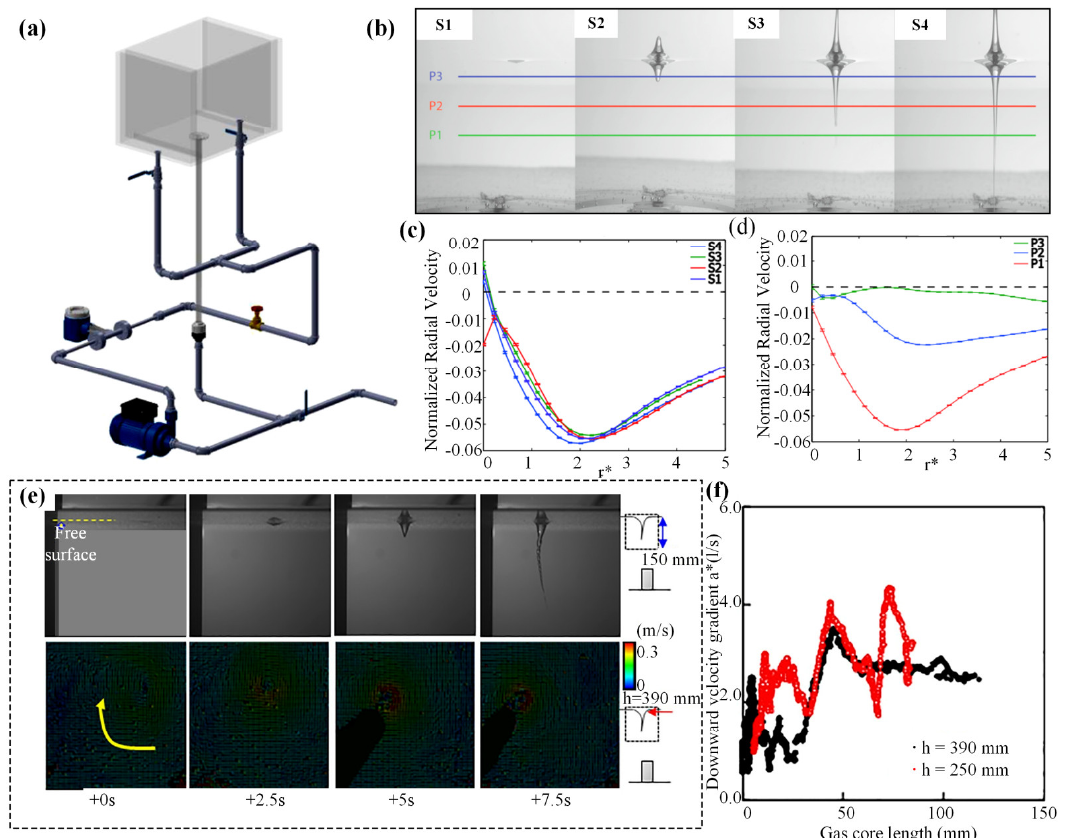
Figure 14. Flow characters of free sink vortex over time. ( a ) Experimental apparatus of gas entrain- ment. ( b ) Different development stages. ( c ) Normalized radial velocity of section P1. ( d ) Normalized radial velocity of stage S1. (Reprinted with permission from Ref. [114]. 2016, Elsevier). ( e ) Velocity distribution in the intermediate plane. ( f ) Relationship between the downward velocity gradient and the gas core length. (Reprinted with permission from Refs. [114,115]. 2019, Elsevier).